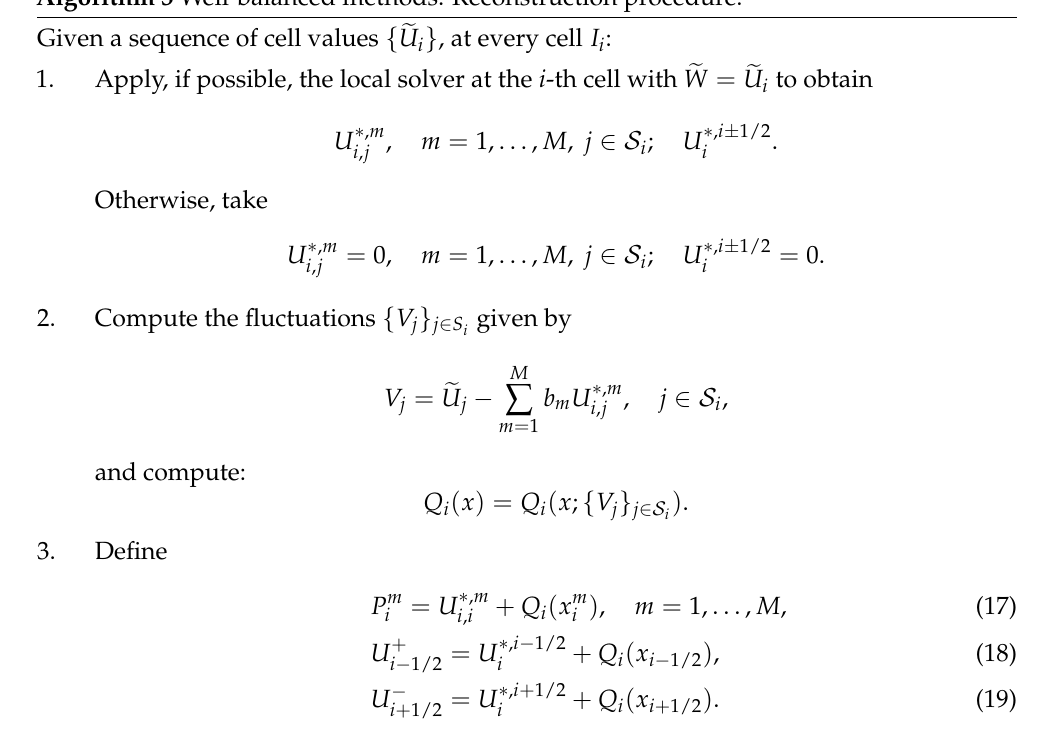
Algorithm 3 Well-balanced methods. Reconstruction